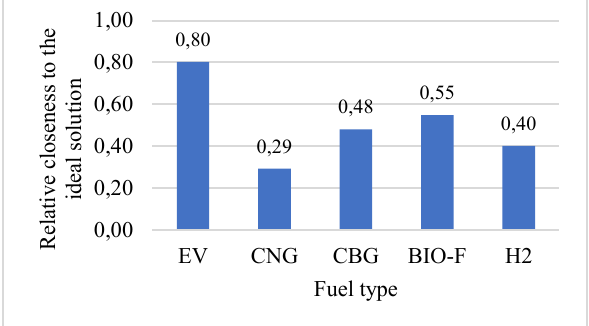
Figure 3. Relative closeness to the ideal solution of each selected fuel type